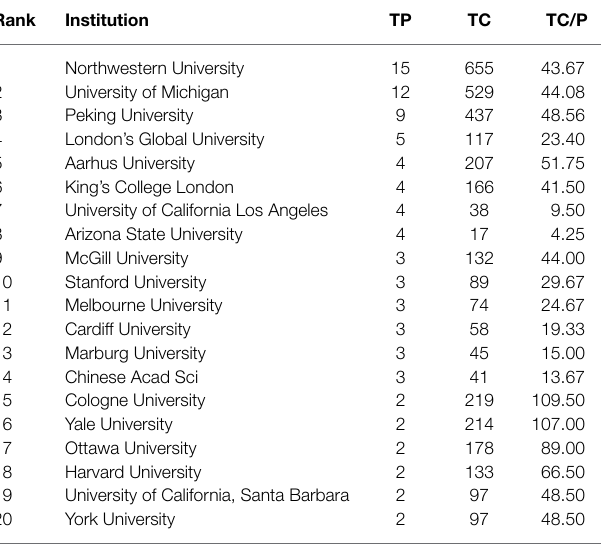
TABLE 3 | Top 20 most influential institutions. TABLE 2 | Top 20 most influential